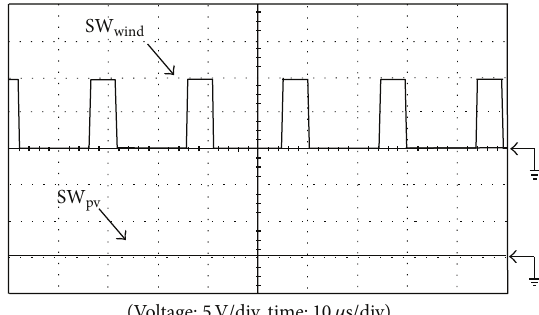
Figure 10: Simulated control signals while wind turbine provides 350